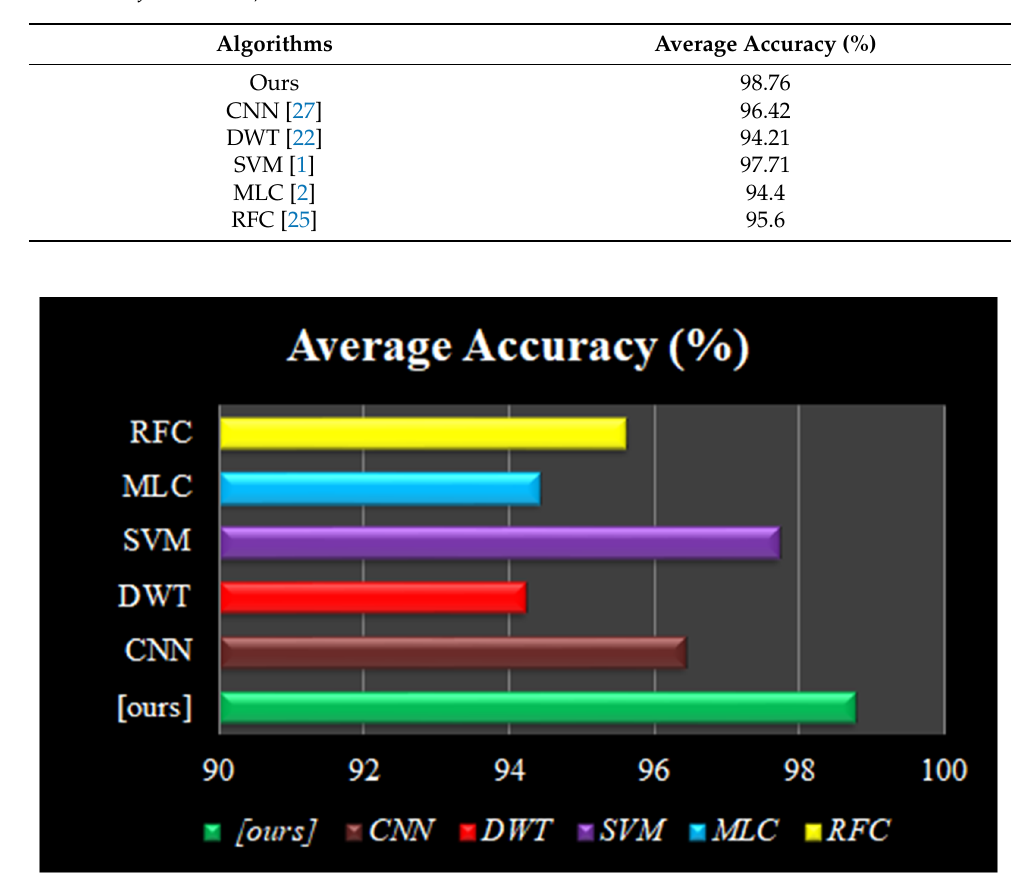
Figure 22. Performance analysis of LU/LC classification model—Javadi Hills, India. Table 12. Comparative analysis of LU/LC prediction models for the area of Javadi Hills,